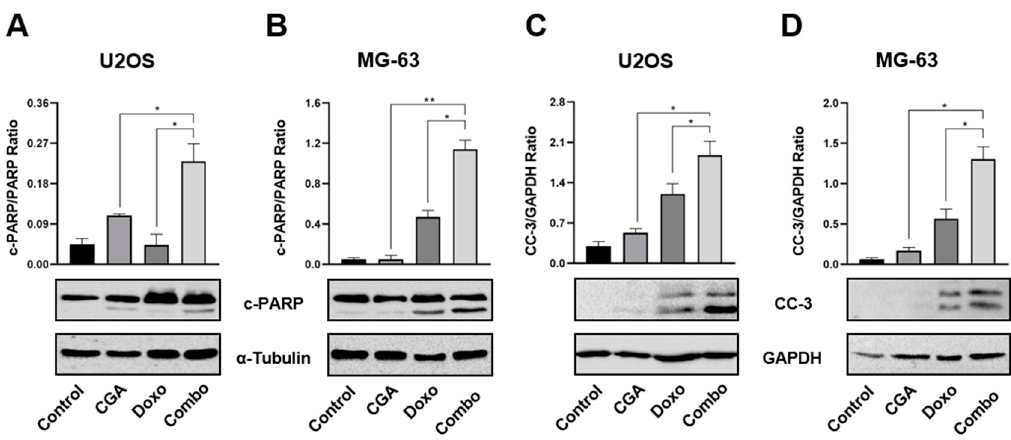
Figure 5. Evaluation of CC-3 and PARP activation in response to CGA, Doxo, and CGA plus Doxo in OS cells. U2OS and MG-63 were exposed and not (control) to 200 µ M of CGA, 0.1 µ M of Doxo, and CGA plus Doxo (combo) for 48 h. Whole extracts were prepared and then samples were analyzed by Western blotting for PARP ( A , B ) or CC-3 ( C , D ) protein levels. GAPDH and α -Tubulin were employed as internal loading controls. Representative Western blotting films were shown in the figure together with the relative densitometric analysis obtained from at least three biological replicates. * p < 0.05, ** p < 0.01 by an unpaired t -test.